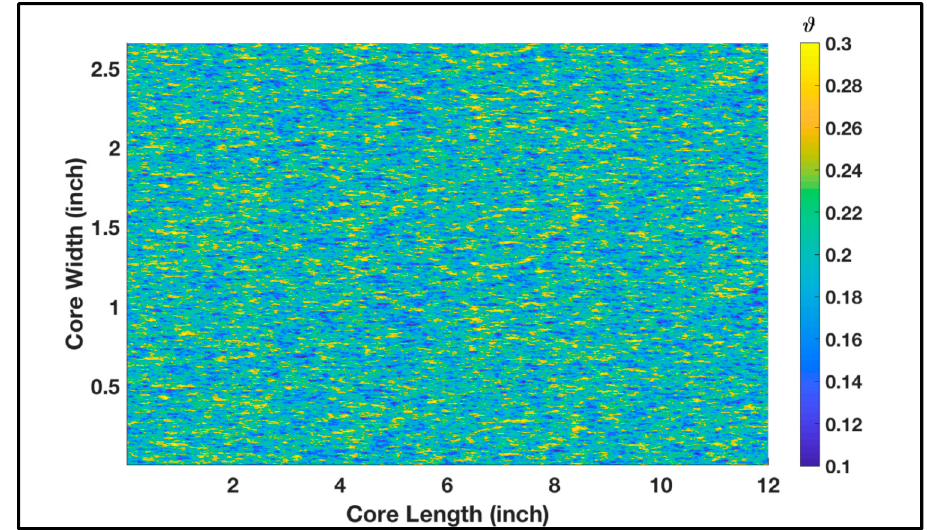
Figure 4. Spatially correlated porosity ( I x = 3.0, I y = 0.8, σ ϕ = 0.04) along the core dimensions before treatment.